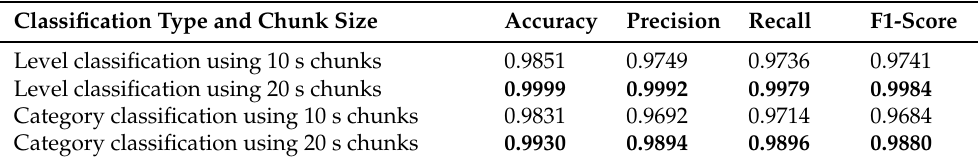
Table 14. Overall classification report of DNN models for aphasia severity level and aphasia category classifications using different lengths of audio